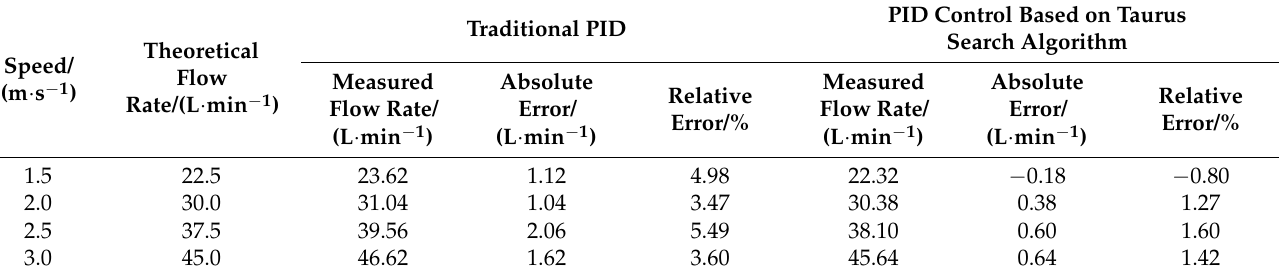
Table 3. System flows control